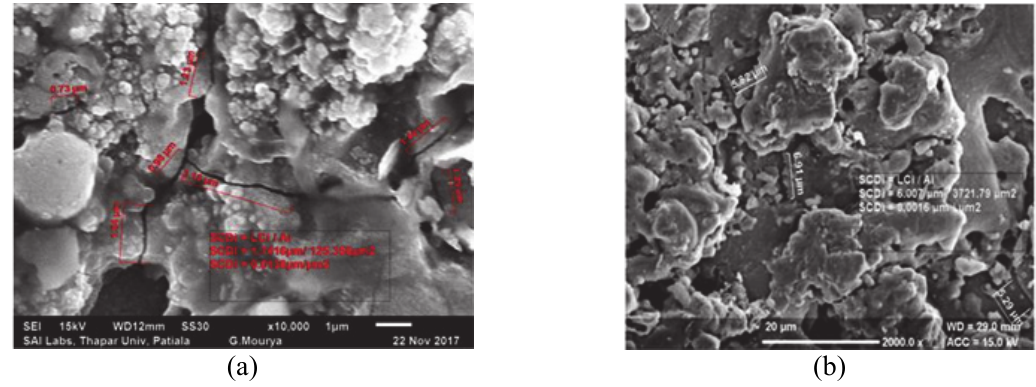
Fig. 2. Total length of the cracks of the given micrograph and total area of the micrograph